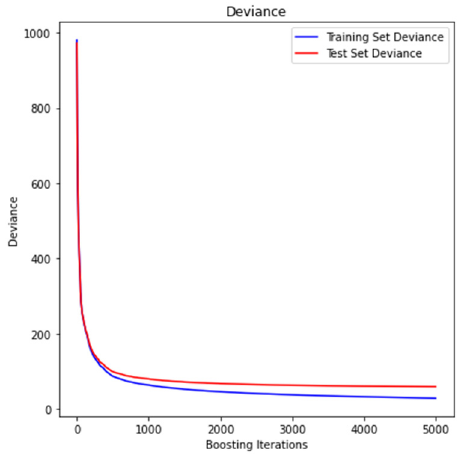
Figure 9. Training and testing MSE as n trees are added to the GBM algorithm.